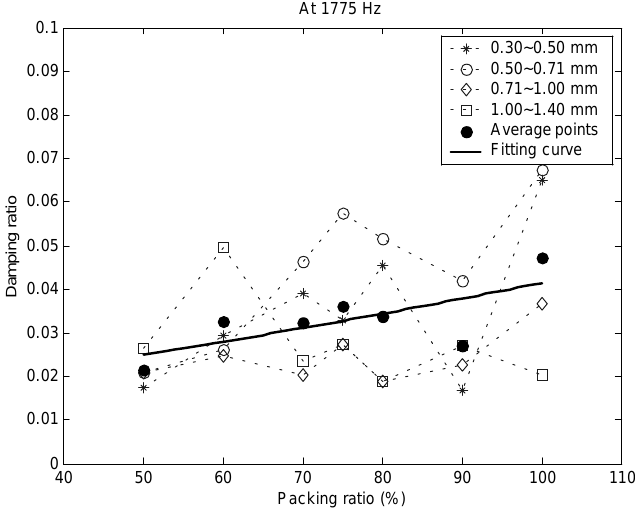
Fig. 6. Damping ratio vs. packing ratio for different particle diameters at 1775